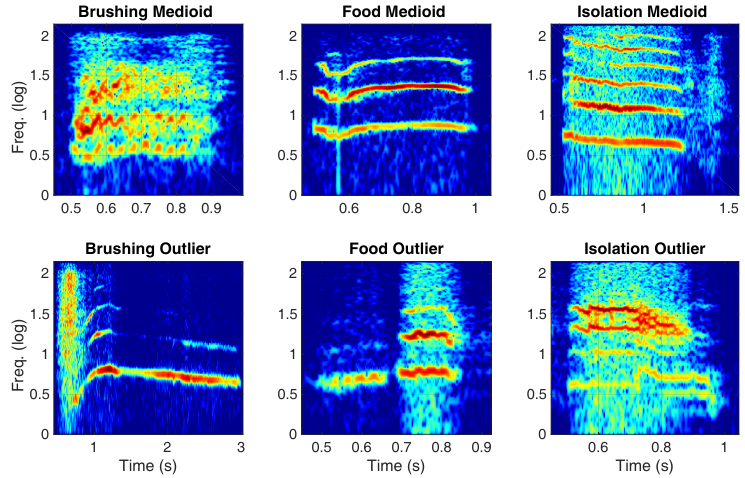
Figure 2. Time–frequency spectrograms of the medioid and outlier meows in the three different